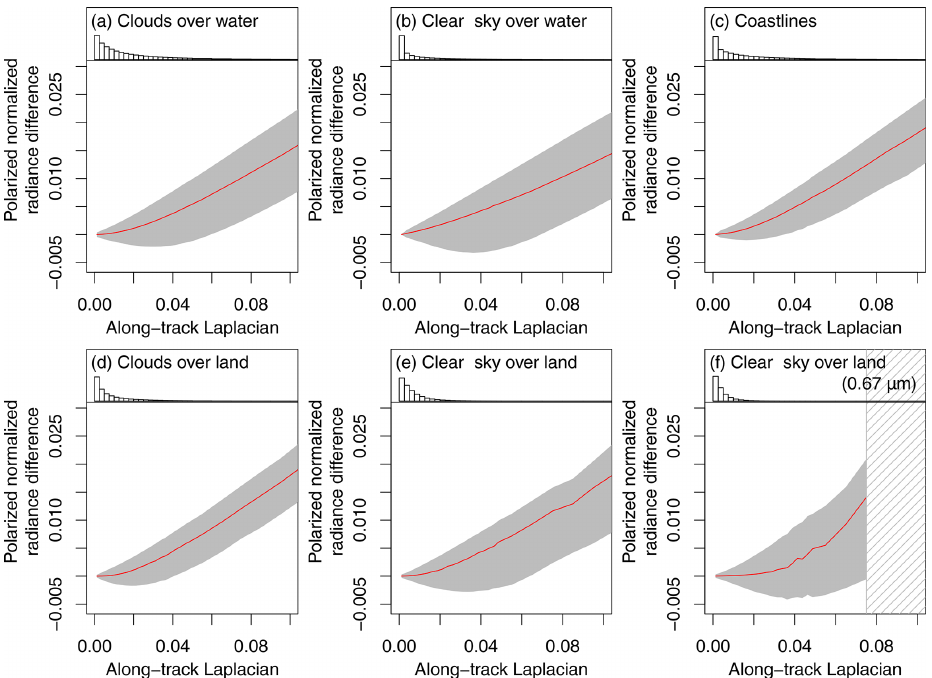
Figure 7. The proxy–reference differences in polarized normalized radiance as a function of the along-track Laplacian. The six panels are for (a) clouds over water, (b) clouds over land, (c) coastlines, (d) clear sky over water, (e) clear sky over land, and (f) clear sky over land at 0.674µm. The top histogram shows the data density along the x axis. Red curves represent the median, and gray shading indicates the interquartile range. Gray hatching corresponds to the part where statistics are unavailable or unreliable because of a limited number of data points. Except for (f) , the wavelength is at 0.869µm.